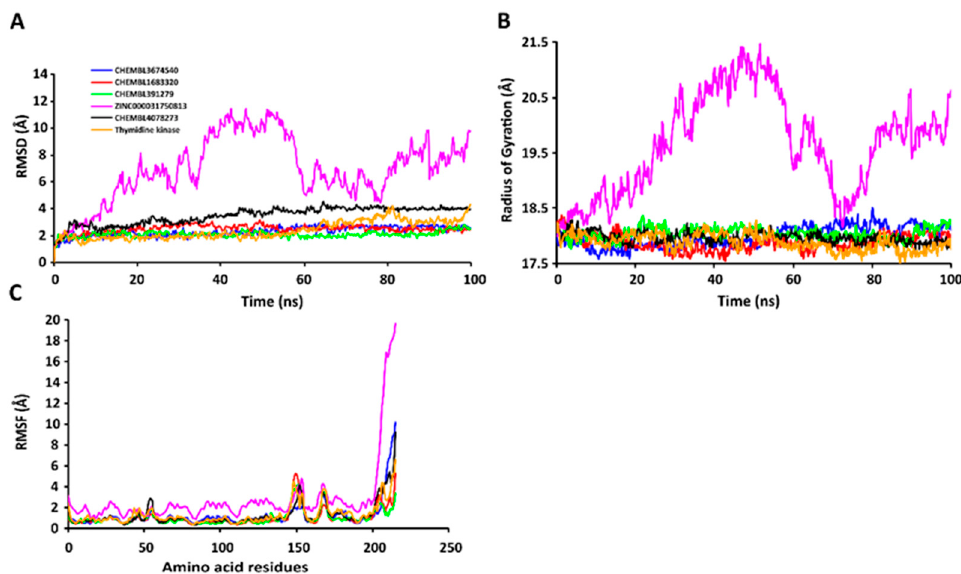
Figure 4. Stabilities of the protein-ligand complexes during 100 ns MD simulations. ( A ) RMSD values of the protein-ligand complexes fitted to the C α backbone of CTP synthase. The x -axis depicts the duration of simulation, while the y -axis represents the RMSD. ( B ) Analysis of the Rg values of the protein-ligand complexes. The x -axis depicts the duration of simulation, while the y -axis represents the deviations in Rg. ( C ) The RMSF values of the C α backbone of CTP synthase. The x -axis depicts the total number of residues, while the y -axis represents the RMSF in Å. The different ligands complexed with CTP synthase are represented by lines of different colors.